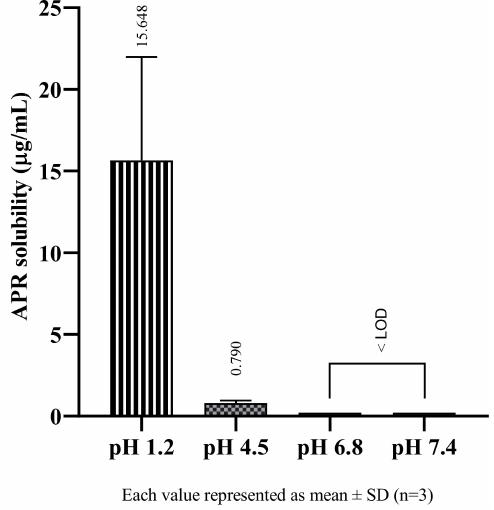
Figure 2. The solubility of APR at 37 ◦ C in buffer